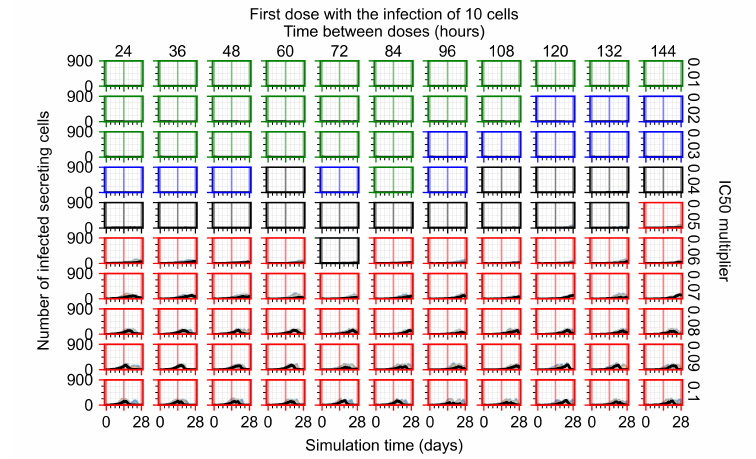
Figure A77. Infected (secreting extracellular virus) population.